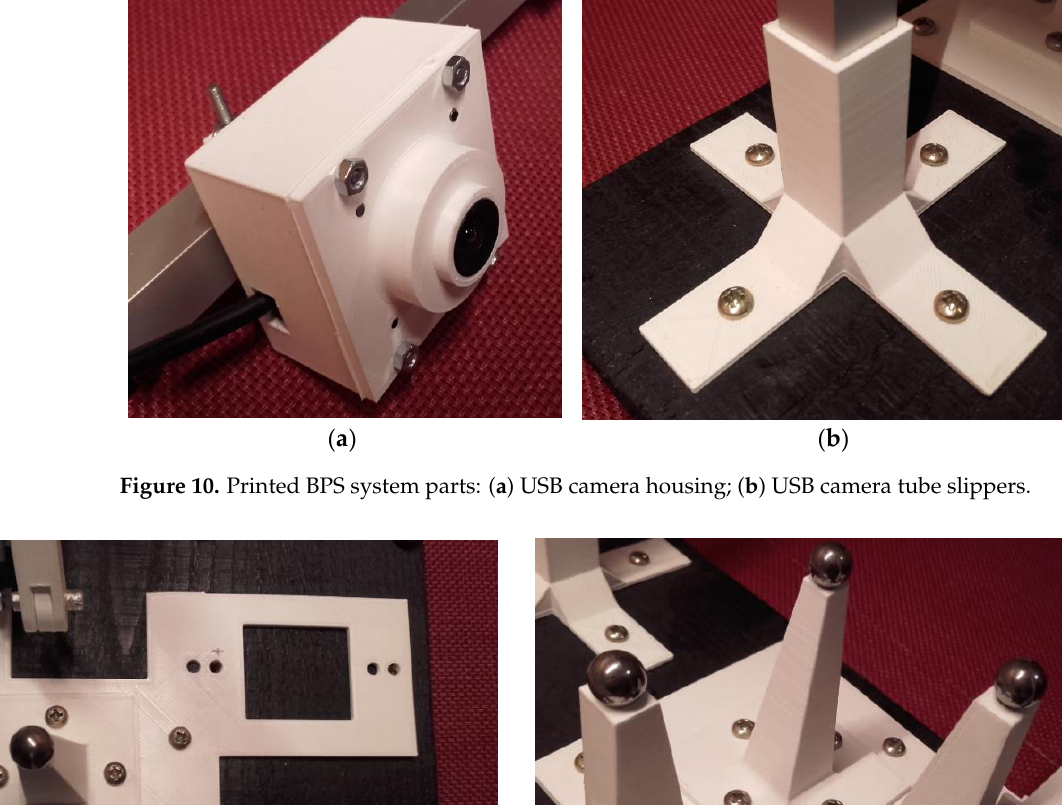
Figure 11. Printed BPS system parts: ( a ) Base plate; ( b ) Three pillars; central fixed pillar and two vertical servo motor knee-arms.